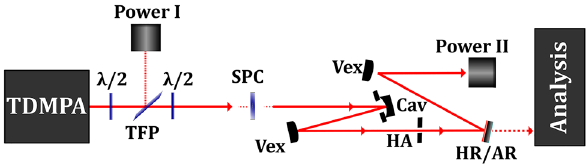
Figure 14: Experimental setup for the conversion of the linear polarization of a beam into radial or